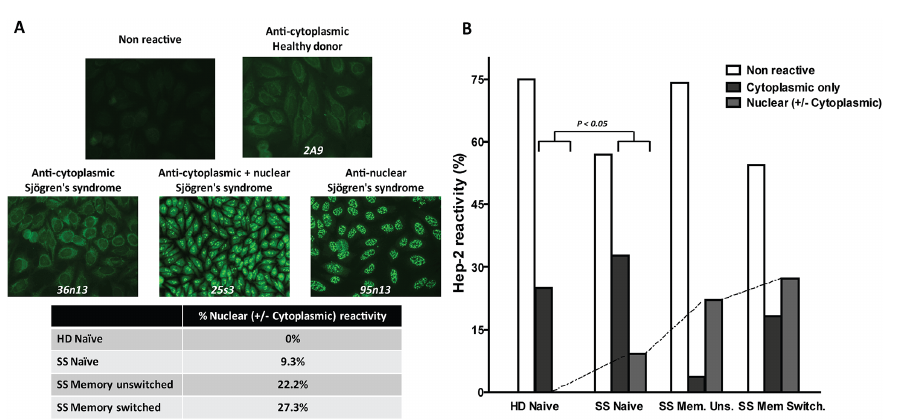
Fig. 6. Hep-2 cell IFA self-reactivity of naı¨ve and memory B cell antibodies from SS patients and HD. Naı¨ve and memory B cell antibodies from SS patients and HD (naı¨ve B cells) were tested for self-reactivity by Hep-2 cell IFA assay. ( A ) Examples of cytoplasmic, cytoplasmic and nuclear, and nuclear Hep-2 cell staining pattern are shown. ( B ) Graph bars summarize the frequency of Hep-2 cell reactive antibodies with cytoplasmic, nuclear and cytoplasmic, nuclear reactivity, and non Hep-2 cell reactive antibodies in SS patients (naı¨ve and memory B cell antibodies) and HD (naı¨ve B cell antibodies). P value compares ANA + (cytoplasmic only and nuclear ¡ cytoplasmic reactive) versus ANA– (non Hep-2 reactive) naı¨ve clones from SS patients and HD. The percentage of self-reactivity for each population is reported over each graph. The number of tested antibodies is indicated below each